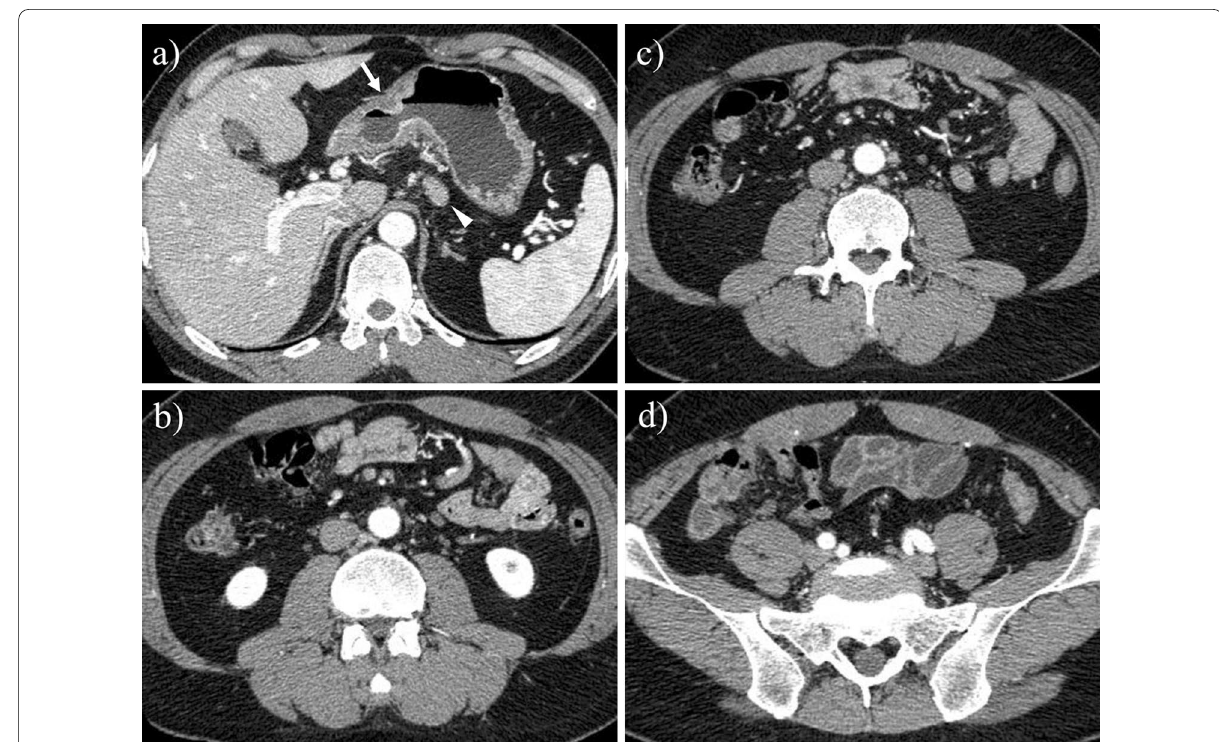
Fig. 1 Preoperative CT. a CT revealed wall thickening with enhancement of the gastric angle (arrow) and regional lymph node swelling (arrowhead). b – d No obvious bone metastasis was